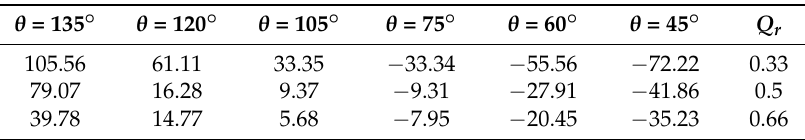
Table 6. Change (%) of D s / B 3 for different θ as compared to θ = 90 ◦ .